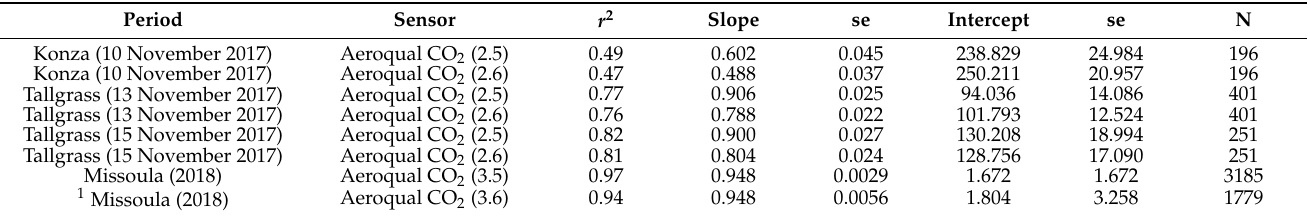
Table A3. Regression statistics for CO 2 sensors versus reference instruments.